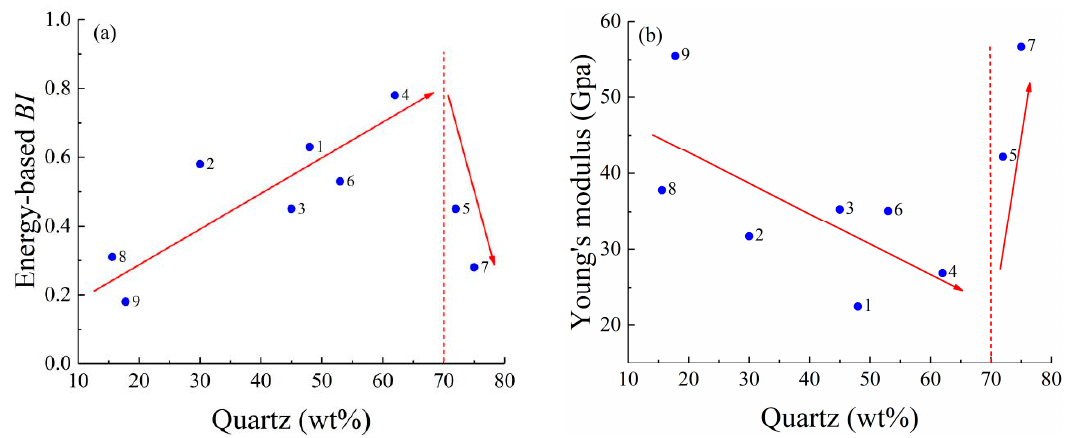
Figure 11. ( a ) Relationship between energy-based BI and quartz content; ( b ) Relationship between Young’s modulus and quartz content.